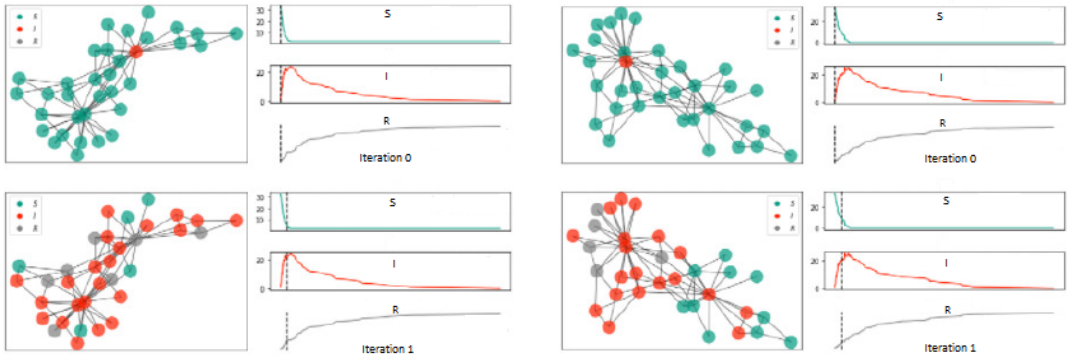
Figure 7. Karate network: using the SIR model for node 1 (first betweenness centrality node— left ) and node 34 (first hub dominance node— right